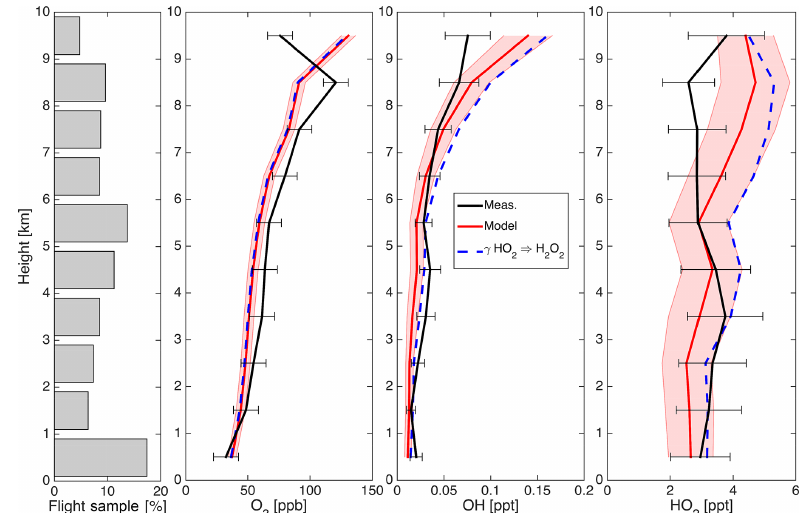
Figure 2. Vertical profiles of mean modeled (red) and measured (black) ozone, OH, and HO 2 for ARCTAS-A flight data binned by kilo- meter. Gray bar graph shows percent of flight data within each vertical bin. Shaded regions represent 1 σ of model ensemble; error bars on measurements are uncertainty at 1 σ confidence. Blue line represents gamma HO 2 producing H 2 O 2 rather than H 2